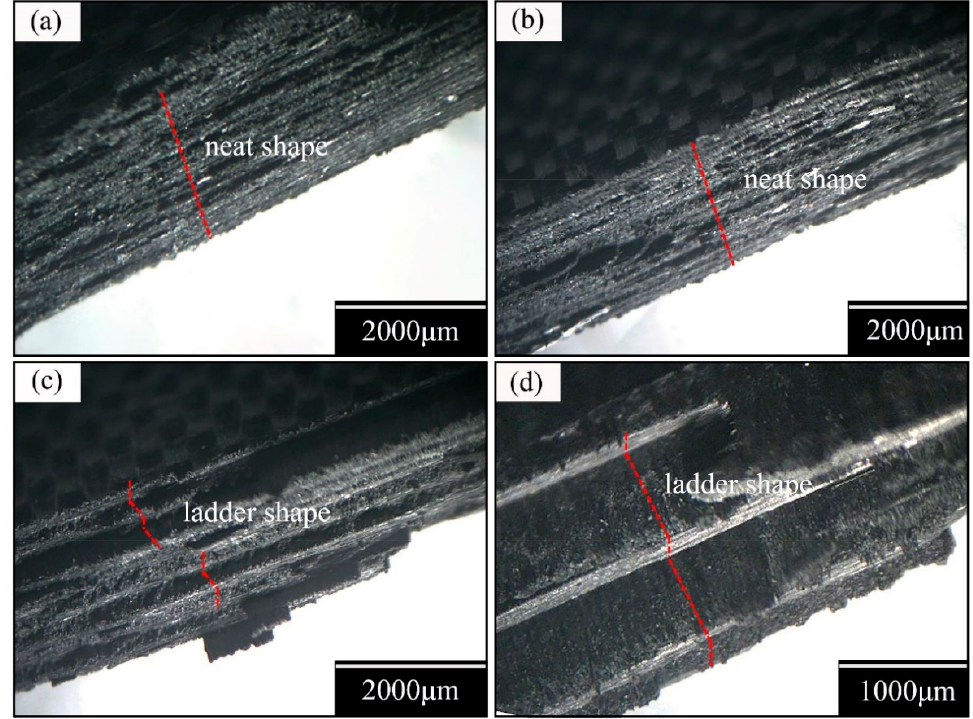
Figure 10. Fracture morphologies under an optical microscope: ( a ) Group A, ( b ) Group B, ( c ) Group C, and ( d ) Group D. and ( d ) Group